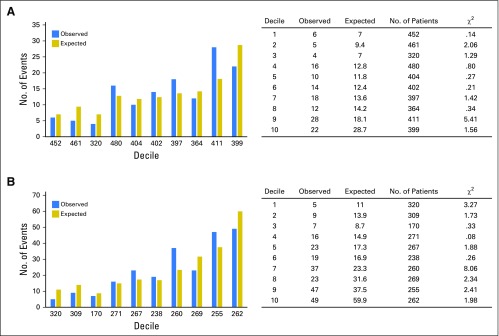
Observed versus expected number of events and χ2 values in the BIG (Breast International Group) 1-98 trial according to deciles of published Clinical Treatment Scores (CTSO) for (A) node-negative and (B) node-positive patients. p < 0.05 when χ2 > 3.84.